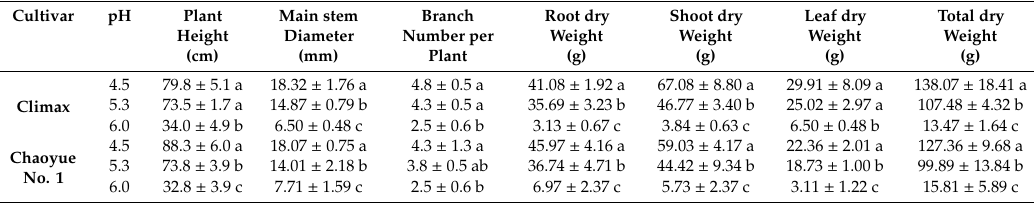
Table 2. E ff ect of di ff erent pH treatments on the plant growth of two